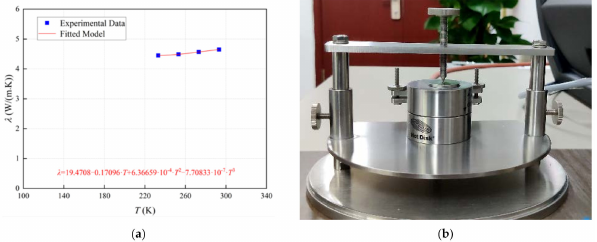
Figure 9. Thermal conductivity of the particles by experiments ( a ) and the testing apparatusHot Disk TPS 2500S ( b ).